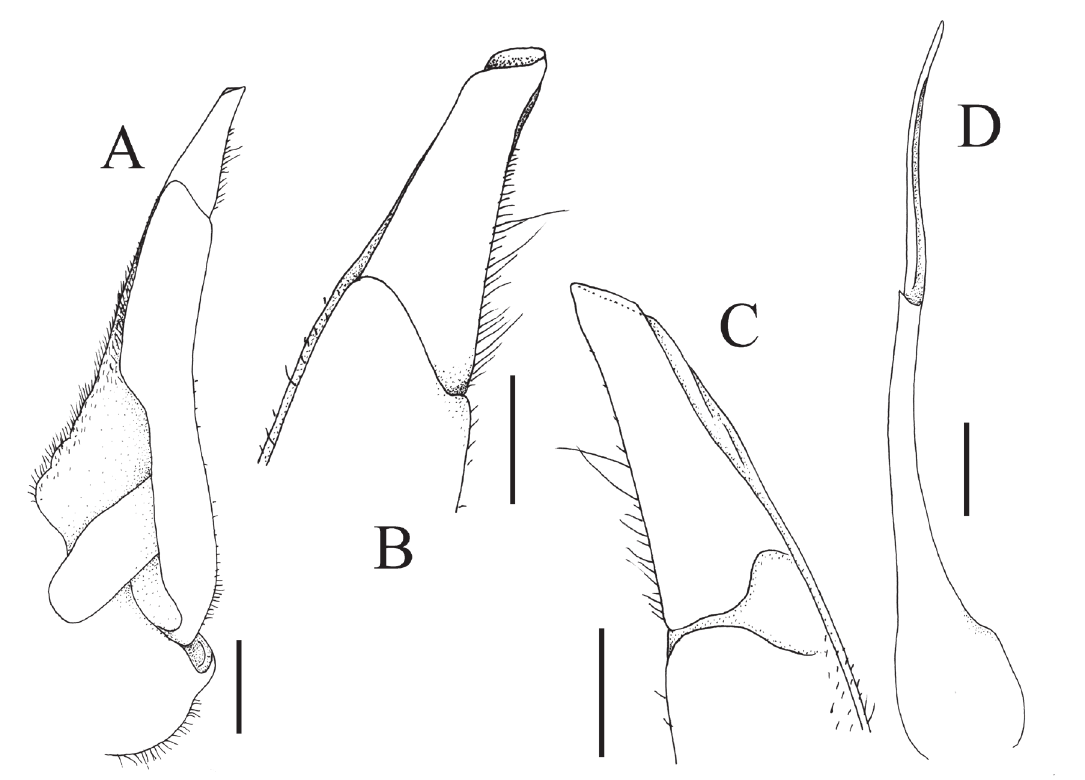
Figure 4. Sundathelphusa tuerkayi , new species, holotype, male (34.7 × 26.5 mm) (SMF 1799a), Lombok, Indonesia. A, ventral view of left G1; B, ventral view of terminal segment of left G1; C, dorsal view of terminal segment of left G1; D, ventral view of left G2. Scales: A, D = 1.0 mm; B, C = 0.5 mm.